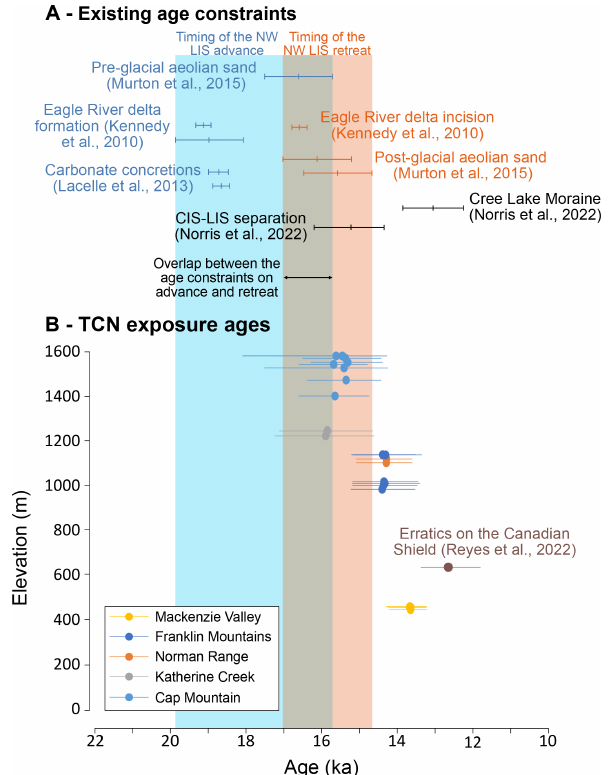
Figure 7. Comparison of our reconstruction of the timing of deglaciation based on the Bayesian model outputs with existing age constraints. The shaded orange area indicates timing of retreat of the NW LIS including dating method uncertainties, and the shaded blue area indicates the timing of advance of the NW LIS including dat- ing method uncertainties based on the age constraints in panel (a) . (a) Existing age constraints on the timing of NW LIS advance and retreat to the LGM. The chronological constraints of the advance of the NW LIS to the LGM are shown as blue lines, and the constraints on the timing of retreat from the LGM are shown in orange. The tim- ing of deglacial events from the multi-chronometer Bayesian model reconstruction of the SW LIS is shown as black points (Norris et al., 2022). Points in this panel are not placed in an elevation sequence. (b) Age–elevation plot using the modelled age distribution output of Bayesian model 2 and 5 (Figs. S3 and S4; Tables S3 and S4). The exposure ages were calculated using the primary calibration dataset (Borchers et al., 2016), LSDn scaling, and a correction for glacioisostatic adjustment (GIA; as described in Sect. 2.1.3).